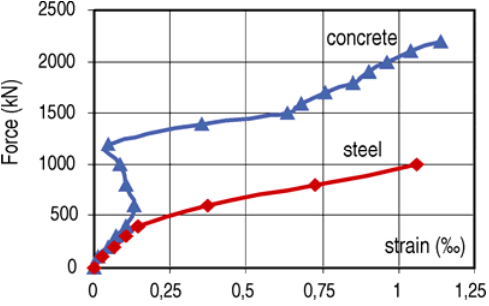
Fig 7 . Strains of steel and concrete in cross-section situ- ated 25 cm from the upper edge